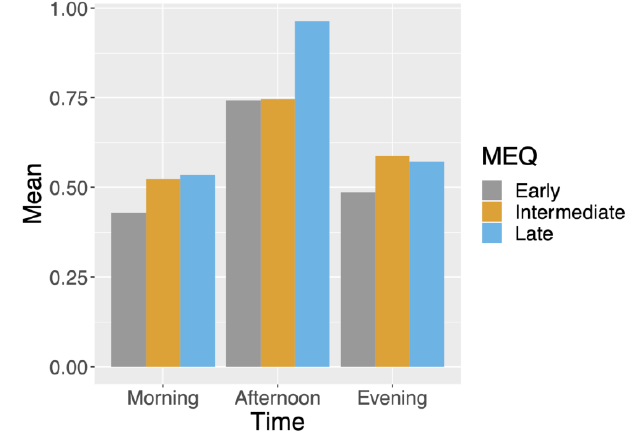
Figure 4. Average missing data for n-back tests by timepoint (morning, afternoon, and evening) and MEQ groupings (early, intermediate, or late).